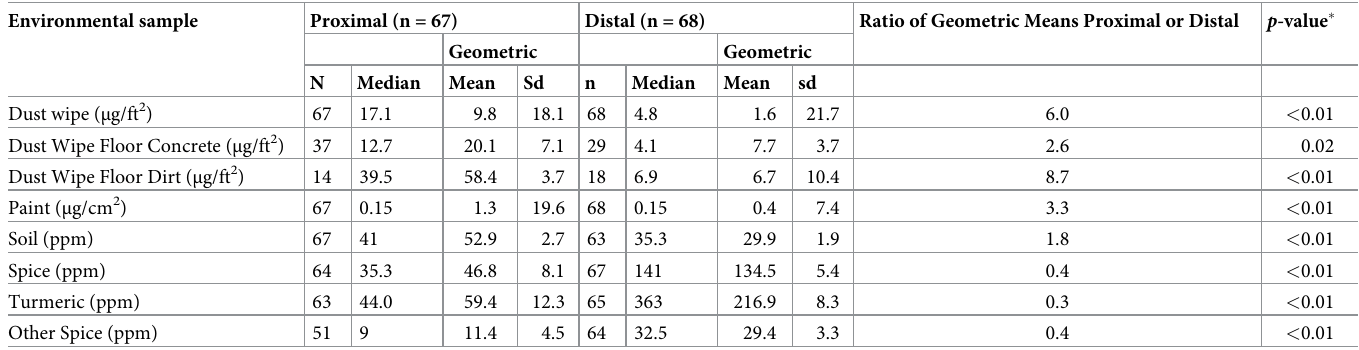
(Table 2). Of 72 interior paint samples tested, 3 (4%) were above the 1 mg/cm 2 lead concentra- tion defining lead hazard (Table 6). Table 3. Lead levels in household environmental samples stratified by distance to ULAB activities, Patna, Bihar, February 2020. Environmental